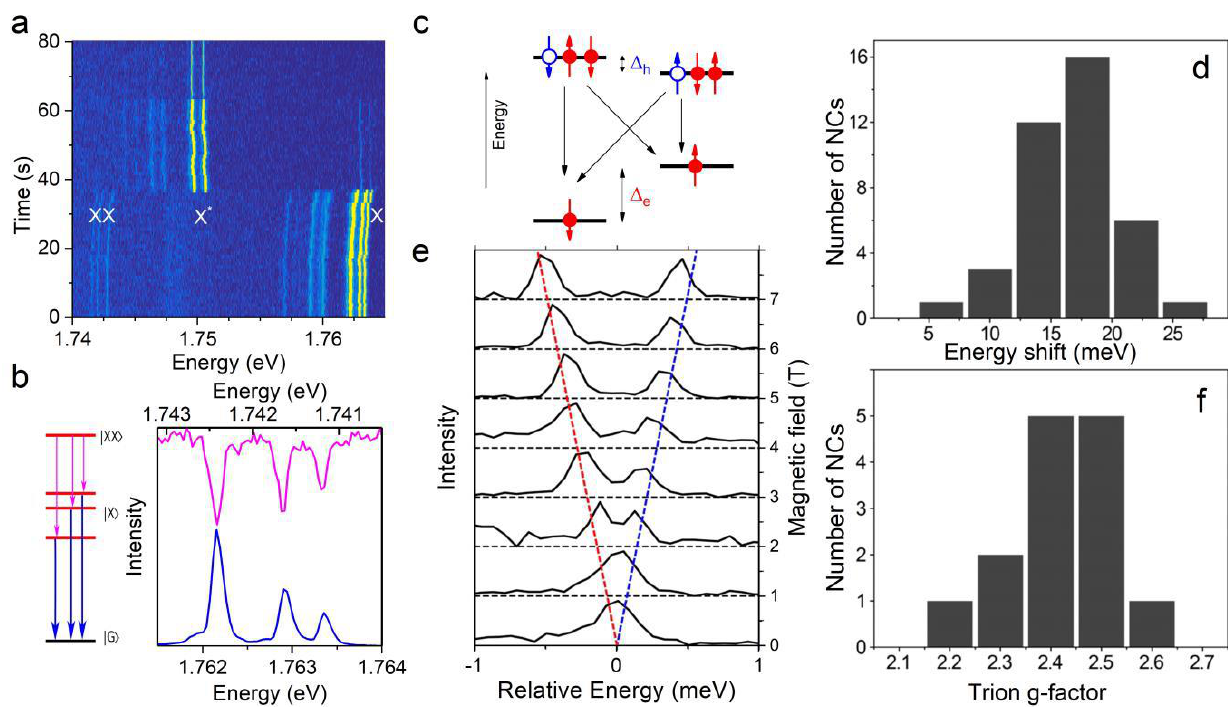
Figure 5. Biexciton and trion spectral signatures. ( a ) Spectral trajectory of a single CsPbI 3 NC. After 38 s, it switches between exciton (X) emission, together with biexciton (XX) emission, and trion (X*) emission. The correspondence between the biexciton spectral structure and the exciton multiplet is evidenced in ( b ). ( c ) Scheme of energy levels and recombination transitions for a negative trion under magnetic fields. The level splitting Δ h associated with the hole is smaller than that associated with the electron Δ e . The red (blue) arrows with solid (hollow) circles represent the spin states of electrons (holes). ( d ) Histogram of the red spectral shifts of the X* structure with respect to X, for 39 single CsPbBr 3 NCs. ( e ) Zeeman splitting of the X* emission line, yielding a trion g-factor of 2.4. ( f ) Histogram of trion g-factors for 14 CsPbBr 3 NCs. Adapted with permission from ref. [30]. Copyright 2017 American Chemical Society. Also adapted from ref. [40].